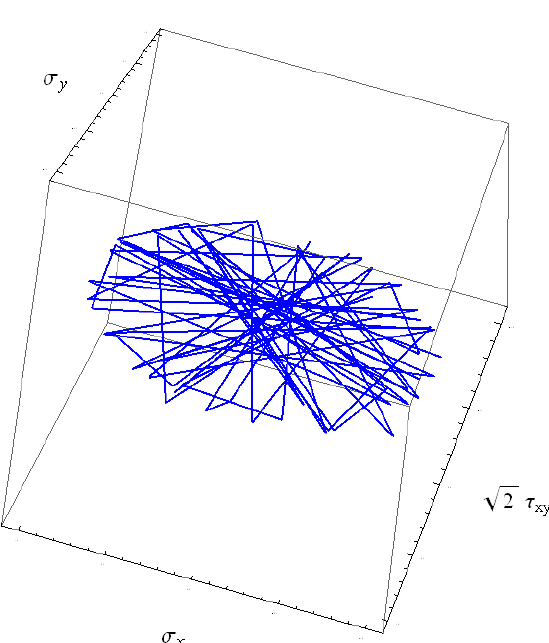
Figure 3: A non-proportional time-dependent tensor path (plane stress):